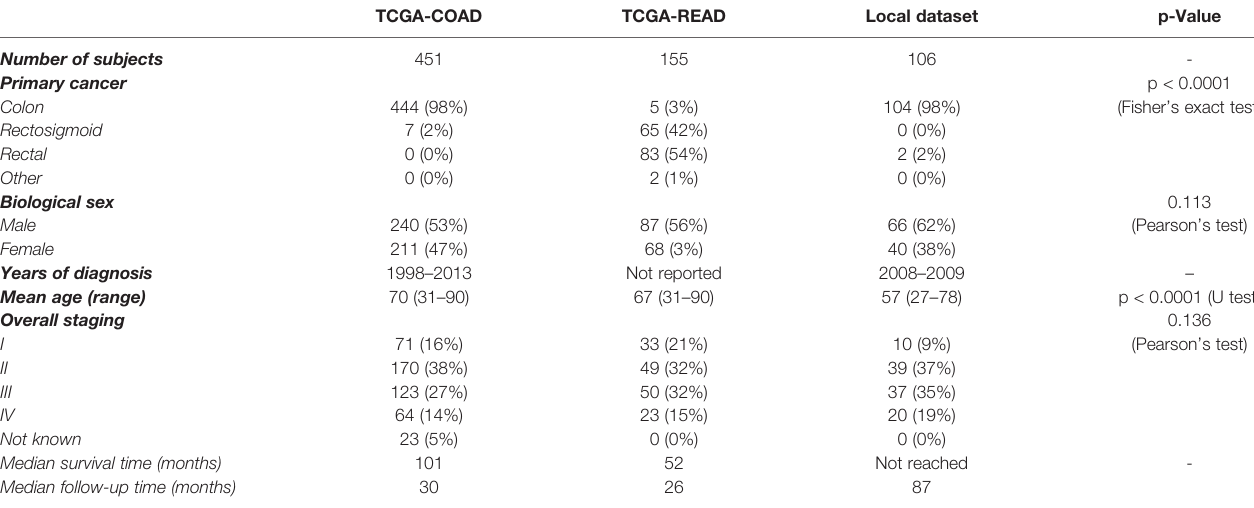
TABLE 1 | Patient characteristics for the datasets of TCGA-COAD, TCGA-READ, and the local institution.